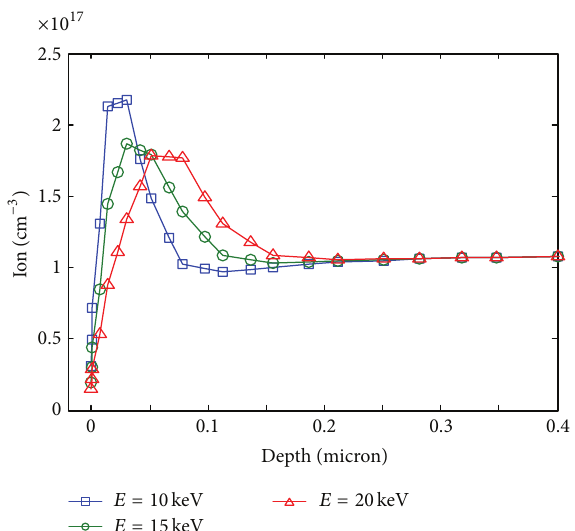
Figure 3: Illustration of ions density distribution between top elec- trode and bottom electrode in the ReRAM device when implanting ions by different